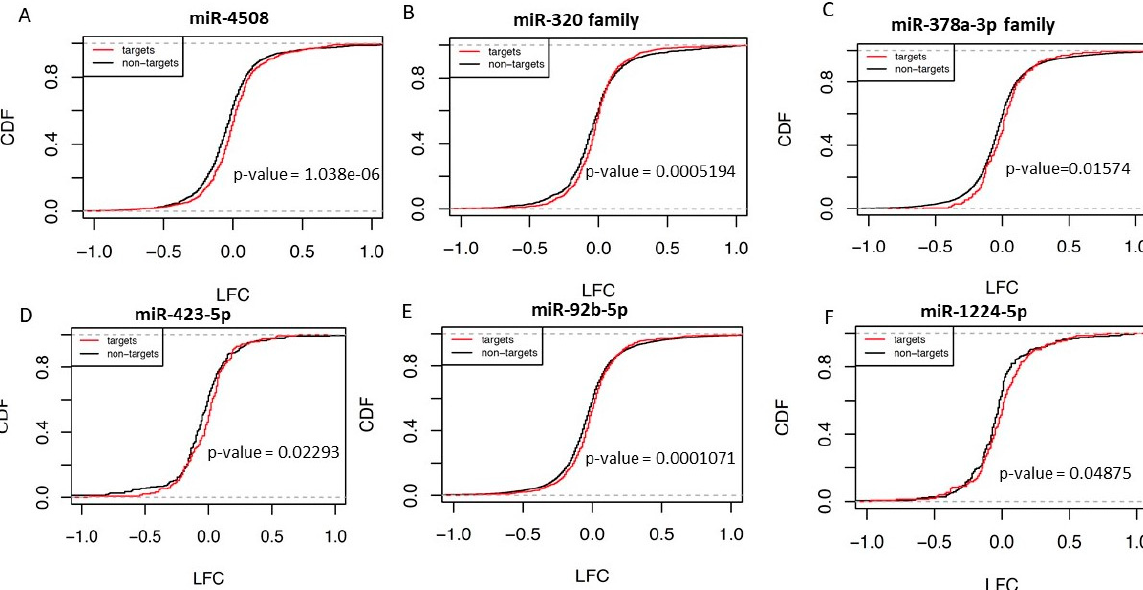
Figure 5. Cumulative distribution plots of mRNAs based on miRNA target status. mRNA targets of downregulated serum miRNAs (miR-4508 ( A ), miR-320 ( B ), miR-378a-3p ( C ), miR432-5p ( D ), miR-92b-5p ( E ) and miR-1224-5p ( F )) are upregulated in the kidney tissue. mRNA targets of miRNA are predicted using TargetScan based on seed sequence complementarity. Non-targets represent mRNA which do not have complimentary seed match with the miRNA.